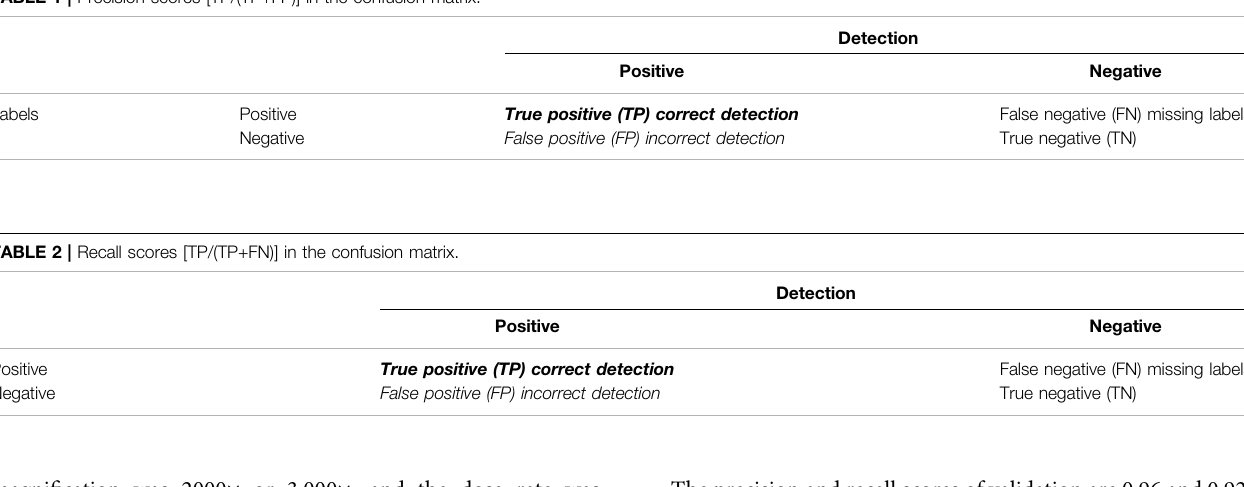
TABLE 1 | Precision scores [TP/(TP+FP)] in the confusion matrix.